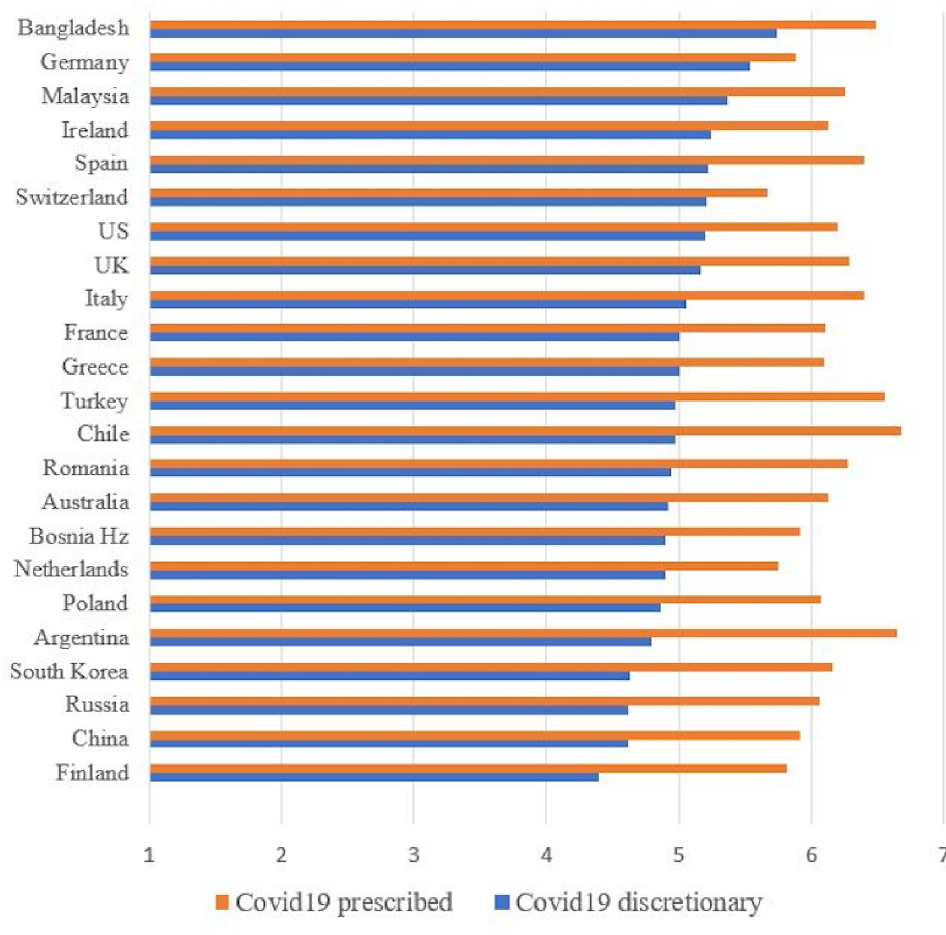
Fig 1. Mean levels of declared compliance to prescribed behaviors and willingness to display discretionary behaviors by country. Countries in the figures are ranked in a descending way according to discretionary behavioral intentions mean